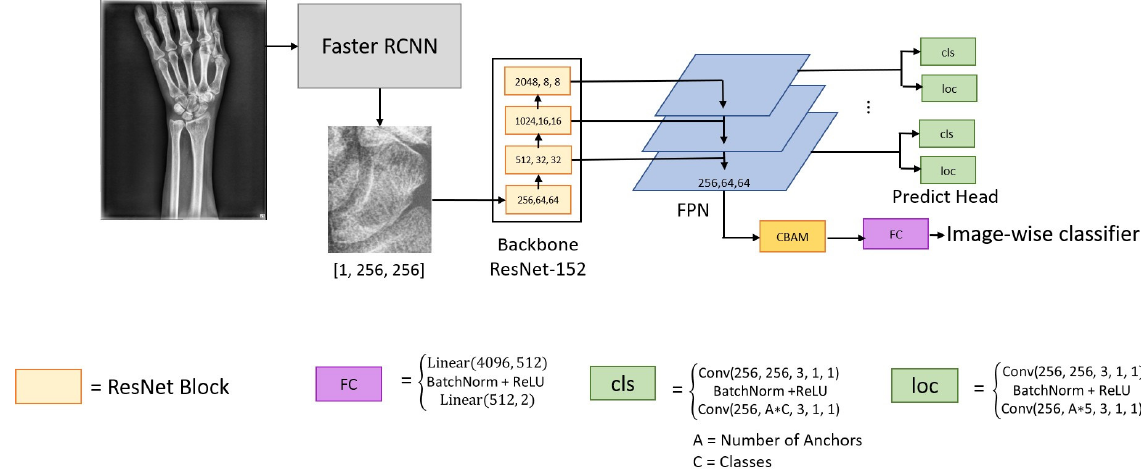
Figure 2. The CNNs used include scaphoid detection and fracture detection.